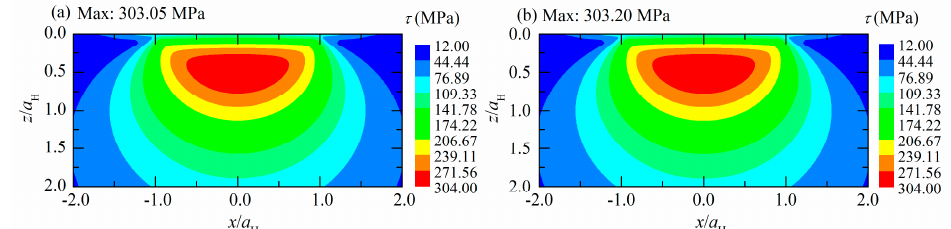
Figure 2. Comparison of the maximum shear stress in x - o - z plane between present solution and the exact analytical solution, ( a ) the maximum shear stress of present solution, ( b ) the maximum shear stress of the exact analytical solution.